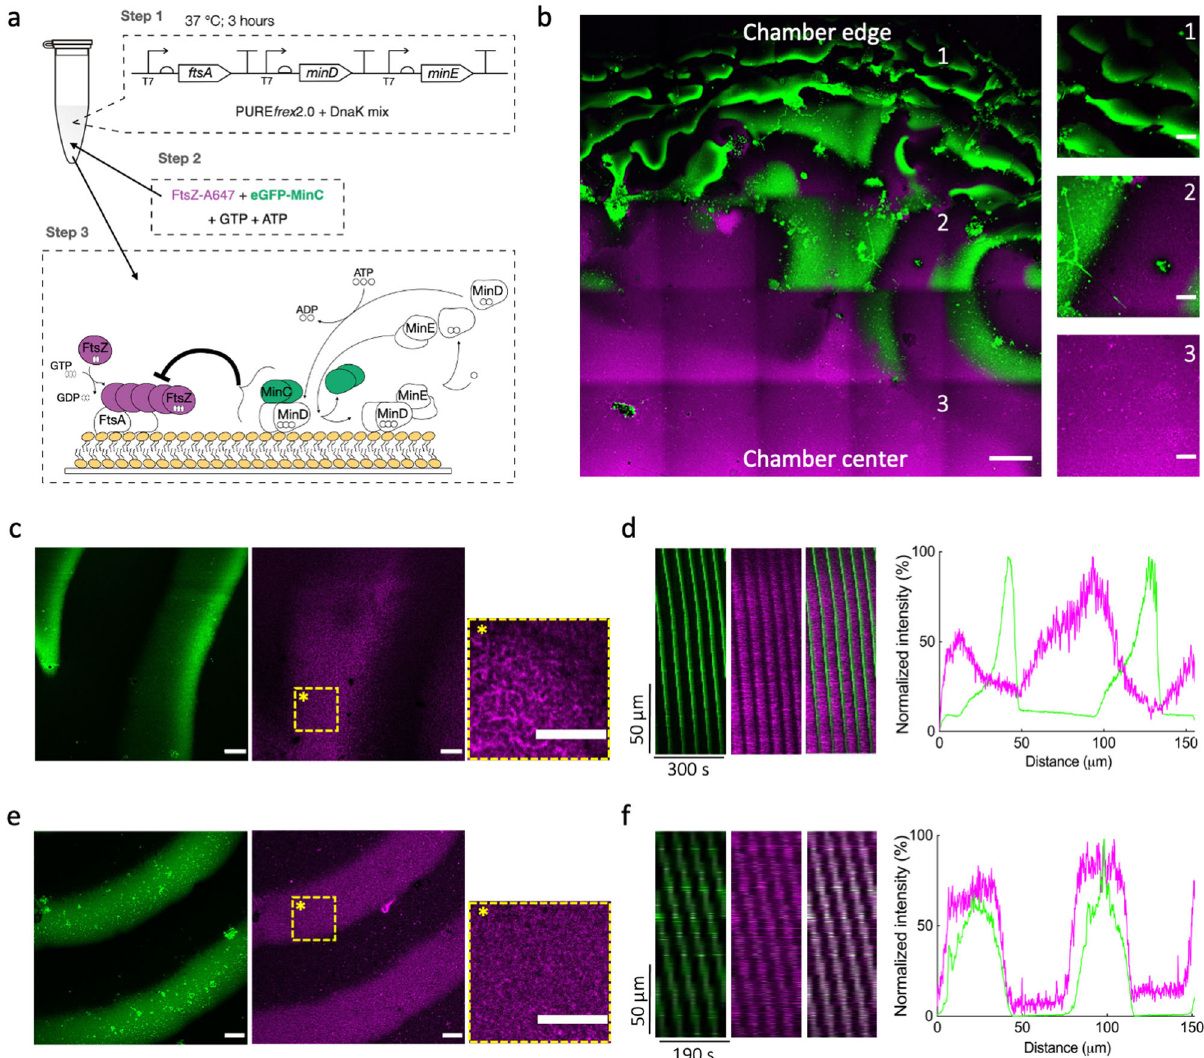
Fig. 2 Integration of MinDEC surface waves with FtsA-anchored FtsZ fi laments on supported membranes. a Schematic of the experimental approach. Genes ftsA, minD and minE were co-expressed from the three-cistron DNA template (5 nM) in PURE system with a DnaK chaperone mix for 3 h at 37 °C. The solution was then supplemented with 2.5 mM ATP, 2.0 mM GTP, 0.5 µ M eGFP-MinC and 3 μ M FtsZ-A647 before transfer on top of an SLB. The cartoon depicts the main biochemical steps underlying FtsZ polymerization, its recruitment to the membrane by FtsA, and the in fl uence of the reconstituted Min network. A schematic of the chamber used in the SLB assays is depicted in (Fig. S2). b Mosaic of 5 × 5 tile scan microscope images showing large-scale organization of FtsA-FtsZ and MinDEC dynamic patterns. FtsA-anchored FtsZ fi laments mostly populate the center of the chamber (3), while MinDEC oscillating gradients dominate at the edges of the chamber (1). In between these two areas (2), correlated patterns of the two subsystems can be seen. Signals from eGFP-MinC and FtsZ-A647 are in green and magenta, respectively. Composite images of overlaid channels are shown. Scale bar is 50 µ m in the mosaic image and 10 µ m in the three zoomed-in images. c Fluorescence microscopy images of FtsA-FtsZ and MinDEC dynamic patterns taken from the intermediate SLB area (2). A zoom-in image of the framed area in the FtsZ channel is also displayed, showing the organization of FtsA-anchored FtsZ into fi laments. Scale bars are 10 µ m. d The time evolution of planar waves was analyzed and kymographs were constructed. On the right, representative intensity pro fi les of MinC and FtsZ are shown. Color coding is the same as for the microscopy images. e Fluorescence microscopy images of FtsZ and MinDEC dynamic patterns when omitting FtsA. A zoom-in image of the framed area in the FtsZ channel is also displayed, showing that in the absence of FtsA, FtsZ fails to organize into cytoskeletal structures. f Kymographs constructed from the time series images shown in ( e ). On the right, intensity pro fi les of MinC and FtsZ signals showing that FtsZ travels with the MinDEC waves in the absence of a membrane